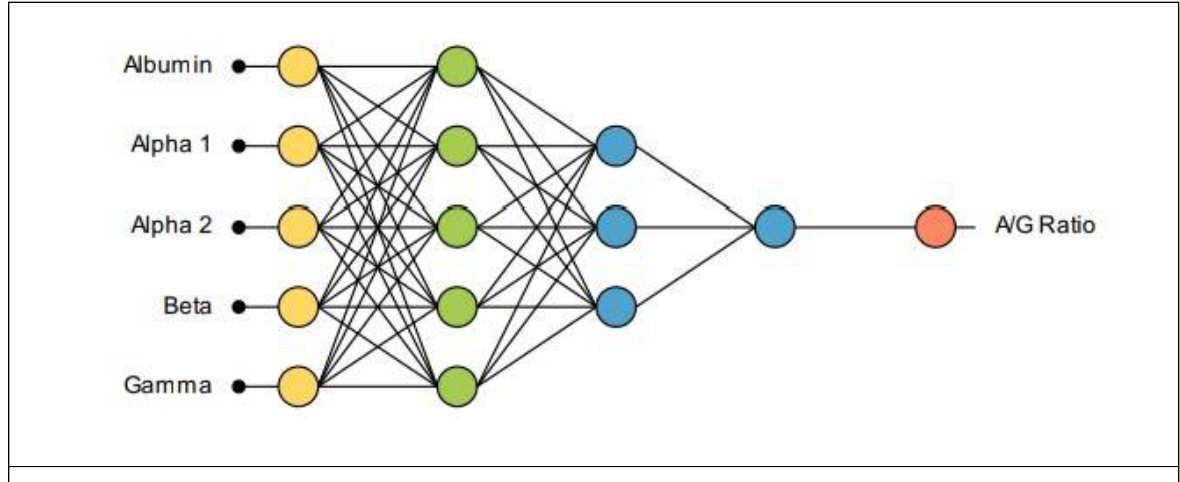
Figure 2: Artificial Neural Network (ANN) architecture